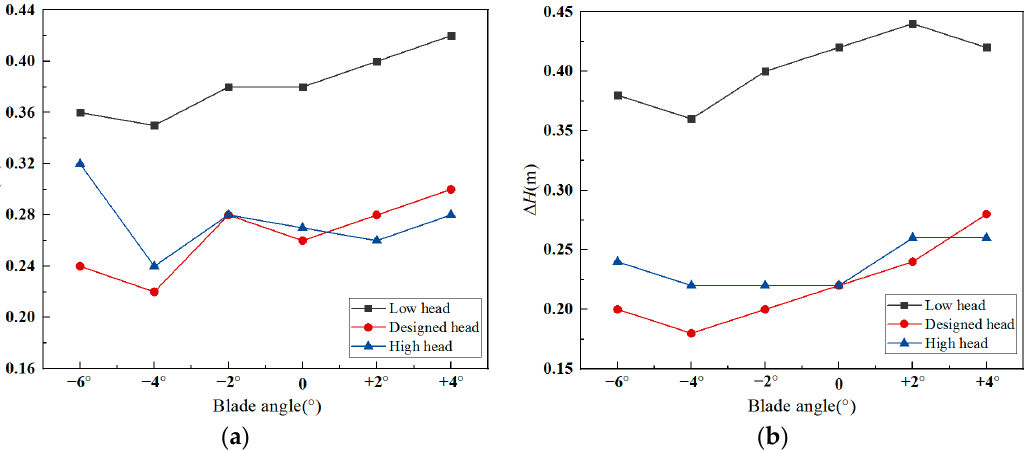
Figure 10. Comparison of peak-to-peak values of pressure pulsation at different blade angles. ( a ) Impeller inlet; ( b ) Guide vane